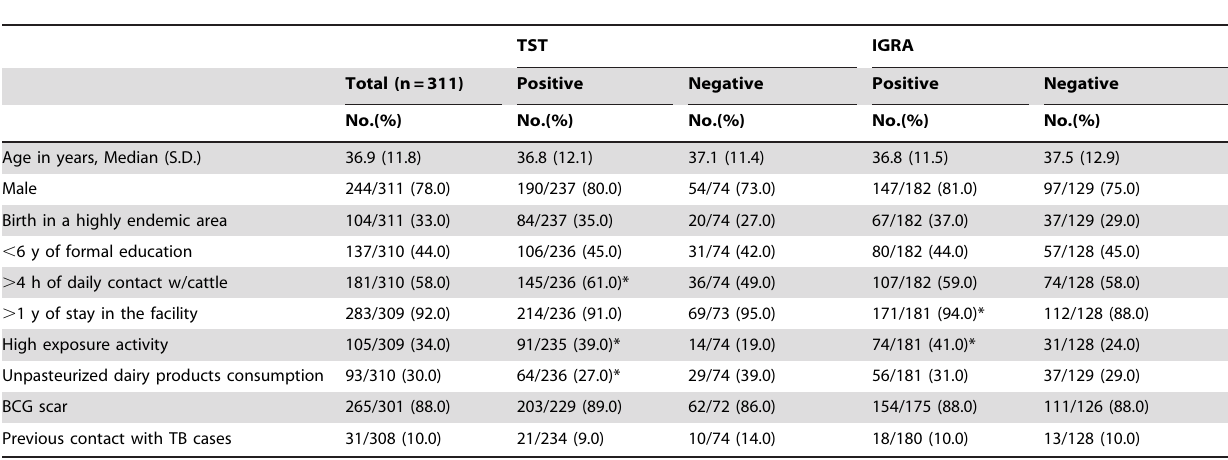
Table 4. Characteristics associated to tuberculosis skin test and interferon- c release